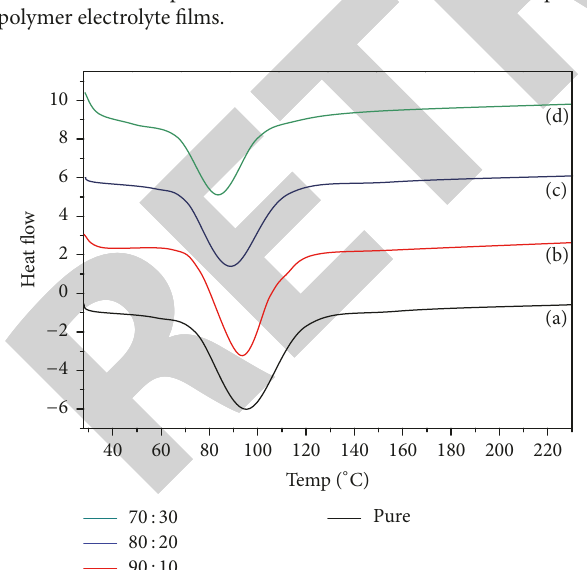
Figure 5: Raman spectra for different wt% ratios of composite polymer electrolyte